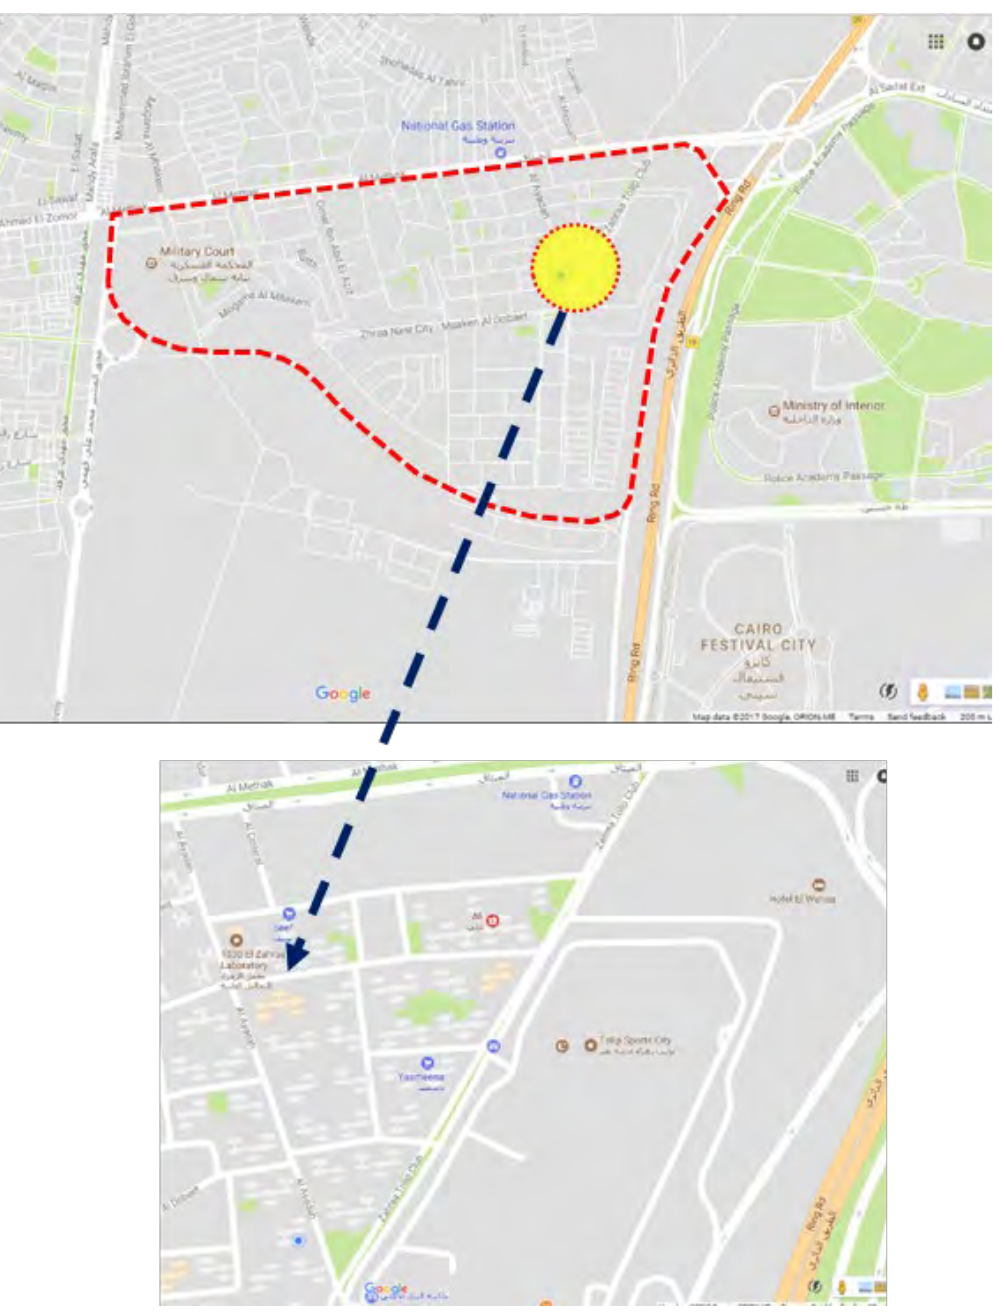
Figure 14. Action area